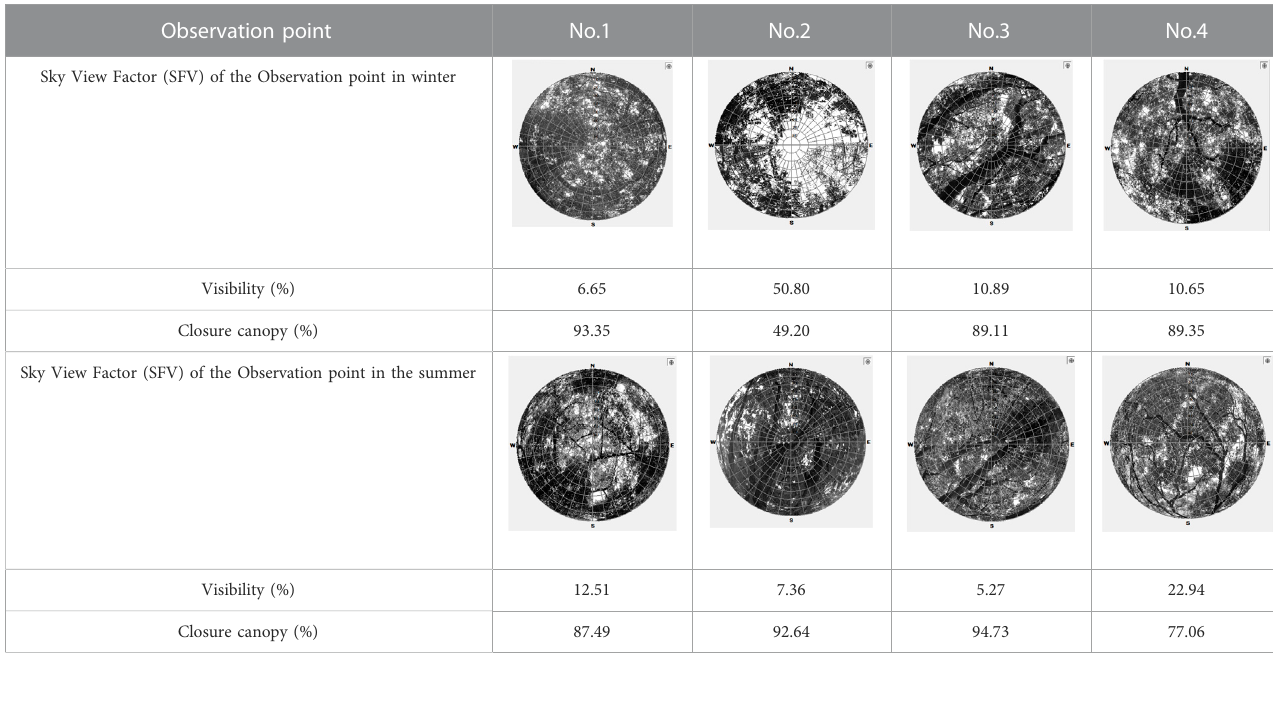
TABLE 3 Closure of the canopy of the four tree species.